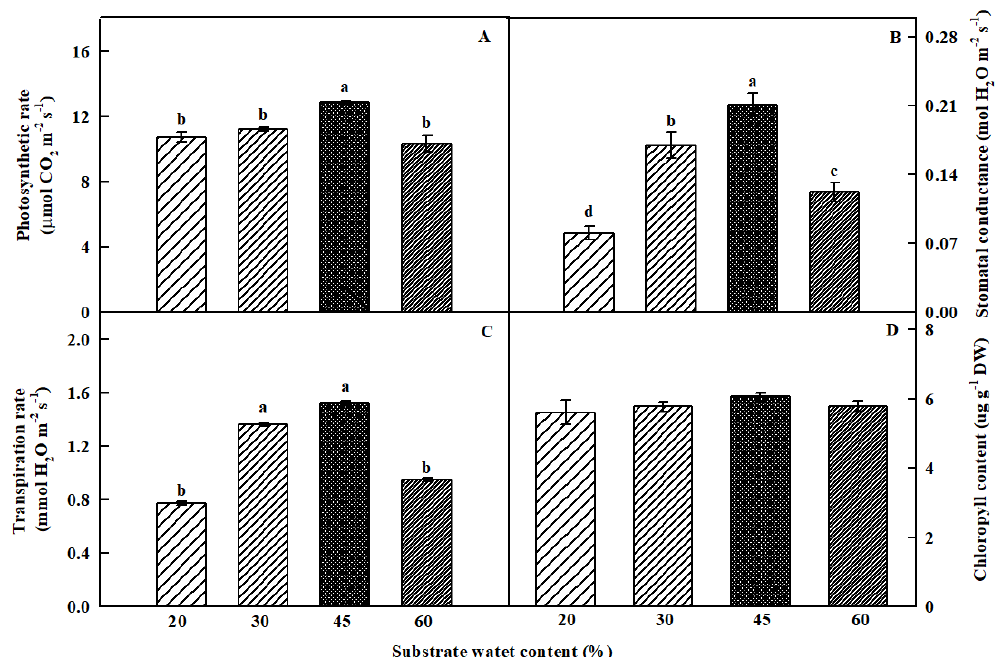
Figure 4. Effect of substrate water content on photosynthetic parameters: Photosynthetic rate ( A ), stomatal conductance ( B ), transpiration rate ( C ) and chlorophyll content ( D ) of Crepidiastrum denticulatum grown under four di ff erent substrate water content levels at 4 weeks after transplanting. The data indicate the means ± S.E. (photosynthetic parameters; n = 6 and chlorophyll content; n = 12). Di ff erent letters above the bars indicate statistical di ff erence by Tukey’s Studentized Range Test at p <